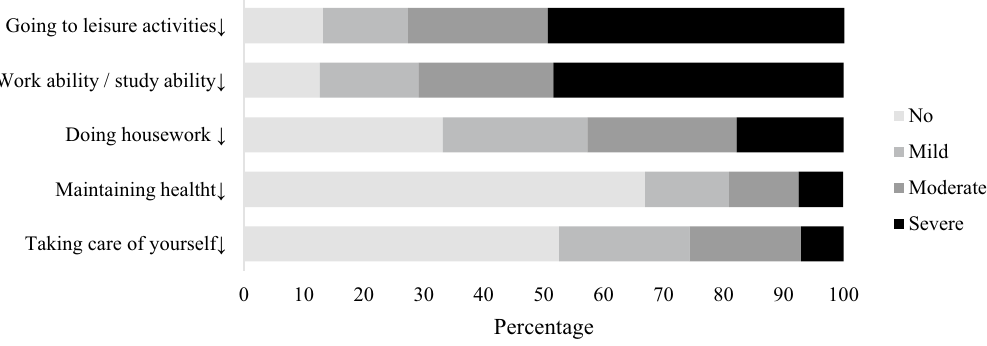
Figure 4. Proportions reporting impairments in activities and participation.